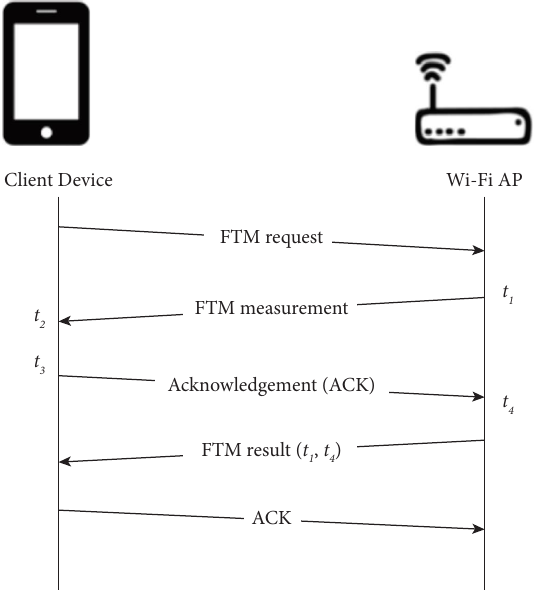
Figure 2: FTM protocol illustration.